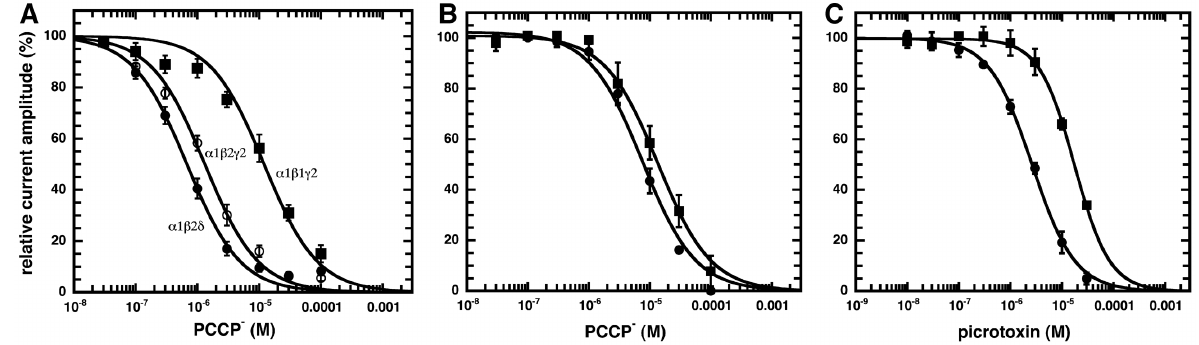
Figure 4. Concentration inhibition curves for rat and Drosophila GABA A receptors. A, Concentration inhibition curve for a 1 b 2 c 2 and a 1 b 2 d GABA A receptors. Increasing concentrations of PCCP 2 were applied together with GABA EC 10 . Individual inhibition curves were standardized and subsequently averaged (Mean 6 SD, n=4). Data are compared with those obtained from a 1 b 2 c 2 receptors. Inhibition of the wild type and mutant RDL Drosophila GABA A receptor by PCCP 2 and Picrotoxin. Concentration inhibition curves of (B) PCCP 2 and, (C) picrotoxin were determined in wild type (circles) and mutant (squares) receptors. Currents were activated with a concentration of GABA eliciting 10% of the maximal current amplitude (EC 10 ) and inhibited with increasing concentration of PCCP 2 or picrotoxin. Individual curves were standardized to initial current amplitudes and subsequently averaged. Data are shown as mean 6 SD